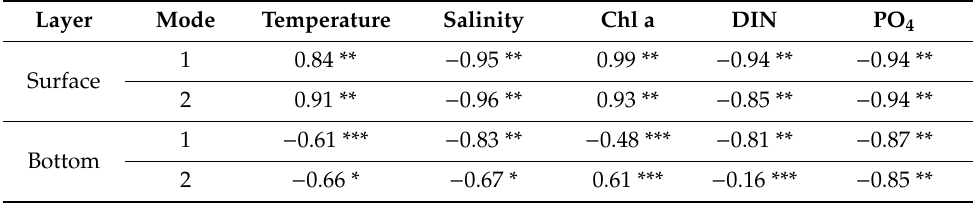
Table 2. Correlation coe ffi cients between the REOFs of DO and those of other environmental factors. Layer